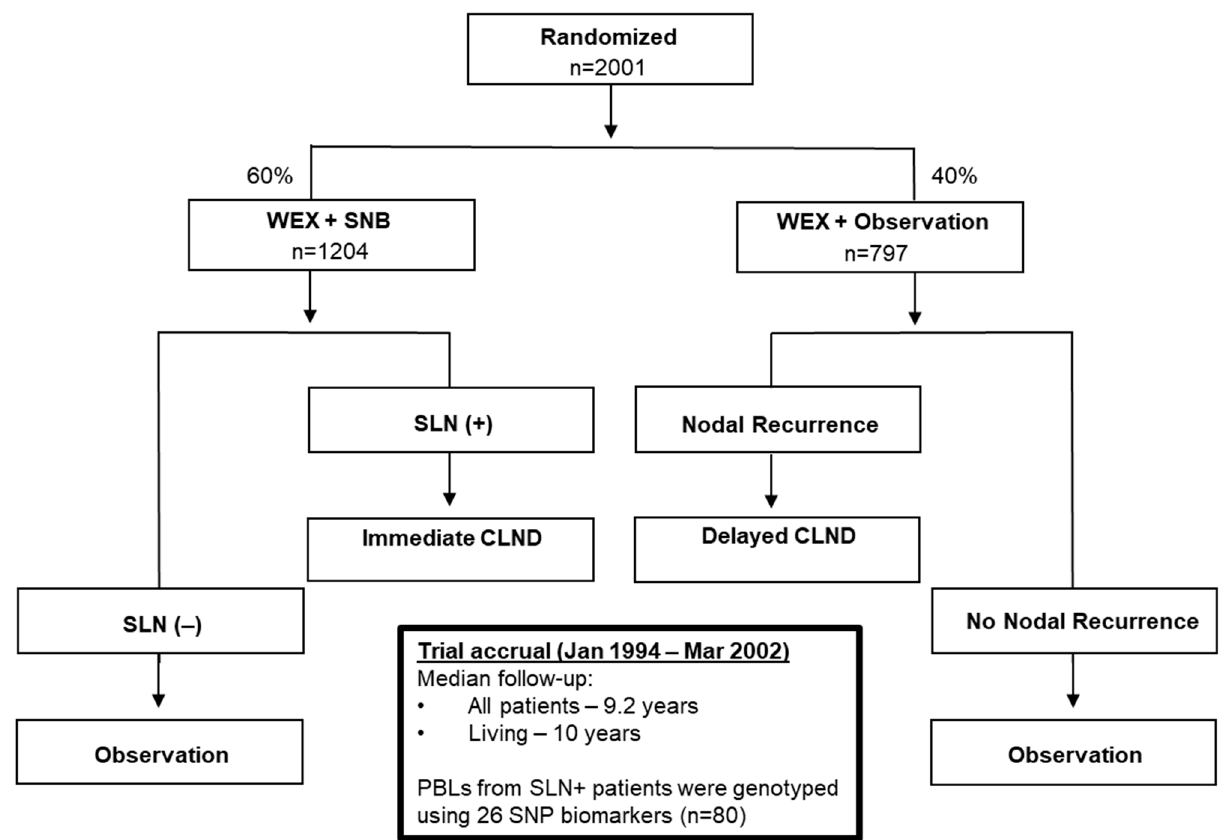
Figure 3. CONSORT diagram of MSLT-I Stage III patients from the phase III randomized double-blinded international multi-center trial. The flow diagram describing the MSLT-I (NCT00275496) trial, is shown. Selected 80 patients from MSLT-I trial were used as a control cohort. MSLT = Multicenter Selective Lymphadenectomy Trial; SLN = Sentinel Lymph Node; WEX = Wide Excision; SLNB = Sentinel Lymph Node Biopsy; CLND = Complete Lymph Node Dissection; PBL = Peripheral Blood Leukocytes; SNP = Single Nucleotide Polymorphism. Blood was taken pre-SLN surgery.